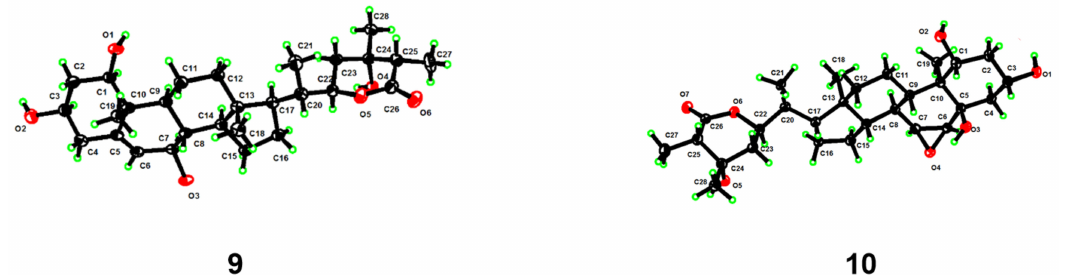
Figure 8. Perspective ORTEP drawings for compounds 9 and 10 .